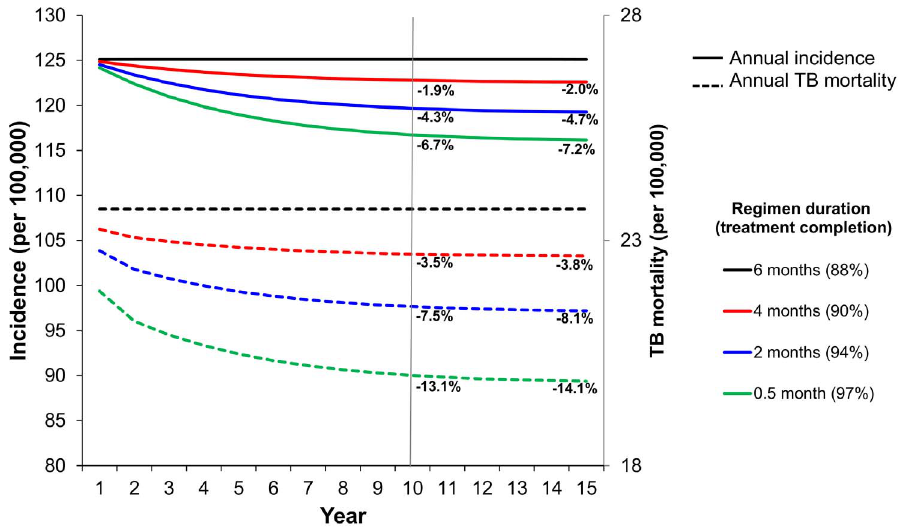
Figure 3. Reduction in TB incidence and mortality achievable from shorter-course regimens over time. Assuming TB incidence of 125 per 100,000/year, and 7% overall treatment default, the implementation of a four-month regimen vs. a six-month regimen results in a 1.9% reduction in incidence at 10 years (vertical line marks year 10 after introduction of a new regimen). Hypothetical two-month and two-week regimens decrease incidence by 4.3% and 6.7% respectively.